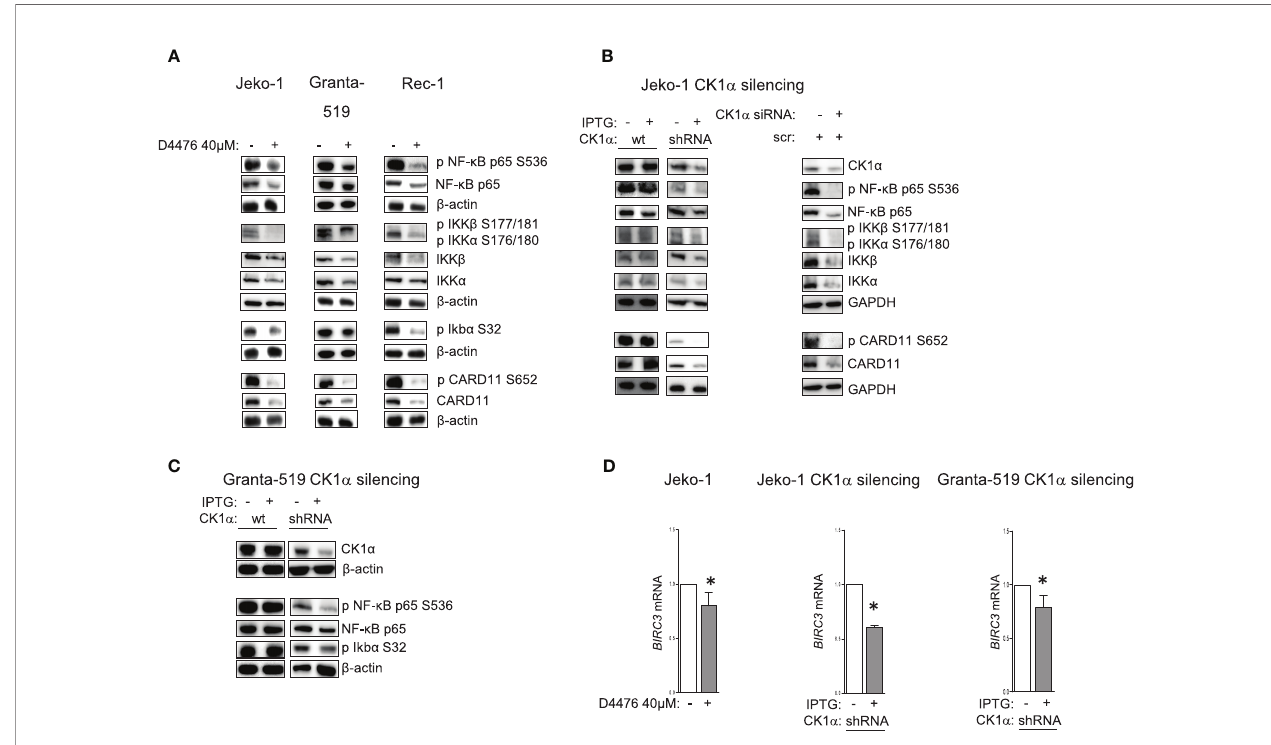
FIGURE 3 | CK1 a sustains NF-kB signaling pathway. Representative WB of NF- ĸ B dependent signaling in MCL cell lines Jeko-1, Granta-519 and Rec-1, treated with D4476 40uM for 48h (A) , in Jeko-1 IPTG inducible CSNK1A1 directed shRNA clone (named CK1 a shRNA) and in Jeko-1 wt treated with IPTG 500µM for 13 days ( B left panel) or Jeko -1 cells electroporated with CSNK1A1 directed siRNAs ( B right panel), or in Granta-519 IPTG inducible CSNK1A1 directed shRNA clone (named CK1 a shRNA) treated with IPTG 500µM for 72h (C) . Membranes for WB analysis were probed with antibodies listed in the fi gure. GAPDH or b actin were used as loading control. Experiments were repeated at least three times (D) . BIRC3 mRNA expression in Jeko-1 treated with D4476 40uM for 48h, (left panel) or in Jeko-1 IPTG inducible CSNK1A1 directed shRNA clone treated with IPTG 500µM for 13 days (middle panel) or in Granta-519 IPTG inducible CSNK1A1 directed shRNA clone treated with IPTG 500µM for 7 days (right panel). Data represent mean ± SD of at least 3 independent experiments. * indicates p <